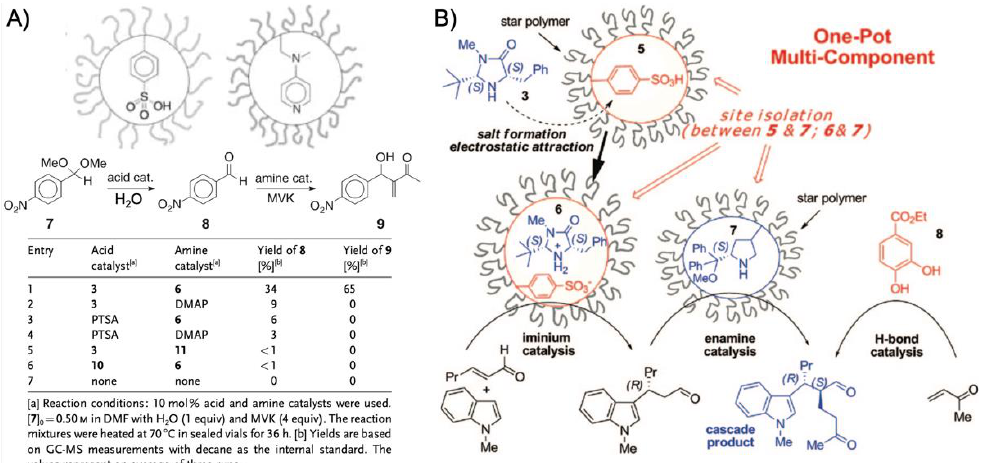
Figure 5. Core-confined acid and base catalysts for cascade reactions. ( A ) PSSA and VEMAP catalysts in star polymer cores performing the acid-base cascade reaction. Reference reactions are given in the table. ( B ) One-pot enantioselective cascade catalysis of site-isolated iminium and enamine catalysts in star polymers. ( A ) adapted with permission of [78]. Copyright 2005 Wiley-VCH. ( B ) reproduced with permission of [79]. Copyright 2008 American Chemical Society.